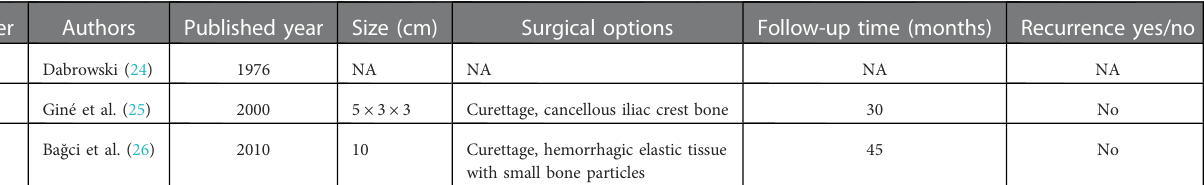
TABLE 1 Summary of all published cases of radial intraosseous